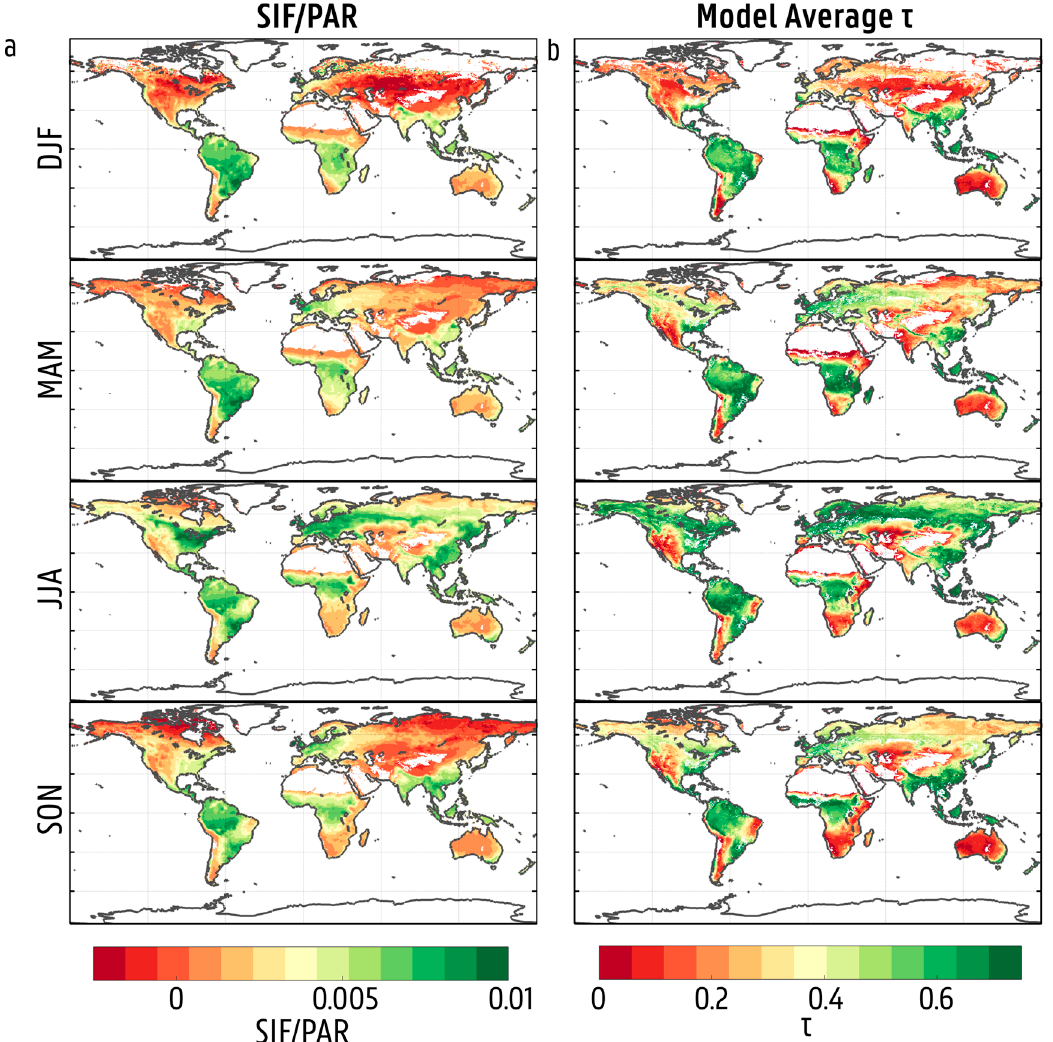
Figure 4. SIF/PAR ( a ) and model ensemble τ ( b ) are averaged across each season (December, January February (DJF); March, April, May (MAM); June, July, August (JJA); and September, October November (SON)) between 2007–2014. Higher values of both SIF/PAR and τ (green regions) indicate unstressed conditions and dense vegetation, while lower values (red regions) indicate greater transpiration constraints. Pixels designated as barren or snow and ice based on the International Geosphere-Biosphere Programme (IGBP) classification are masked out. Pixels with less than 30 days of observations per season are also excluded.